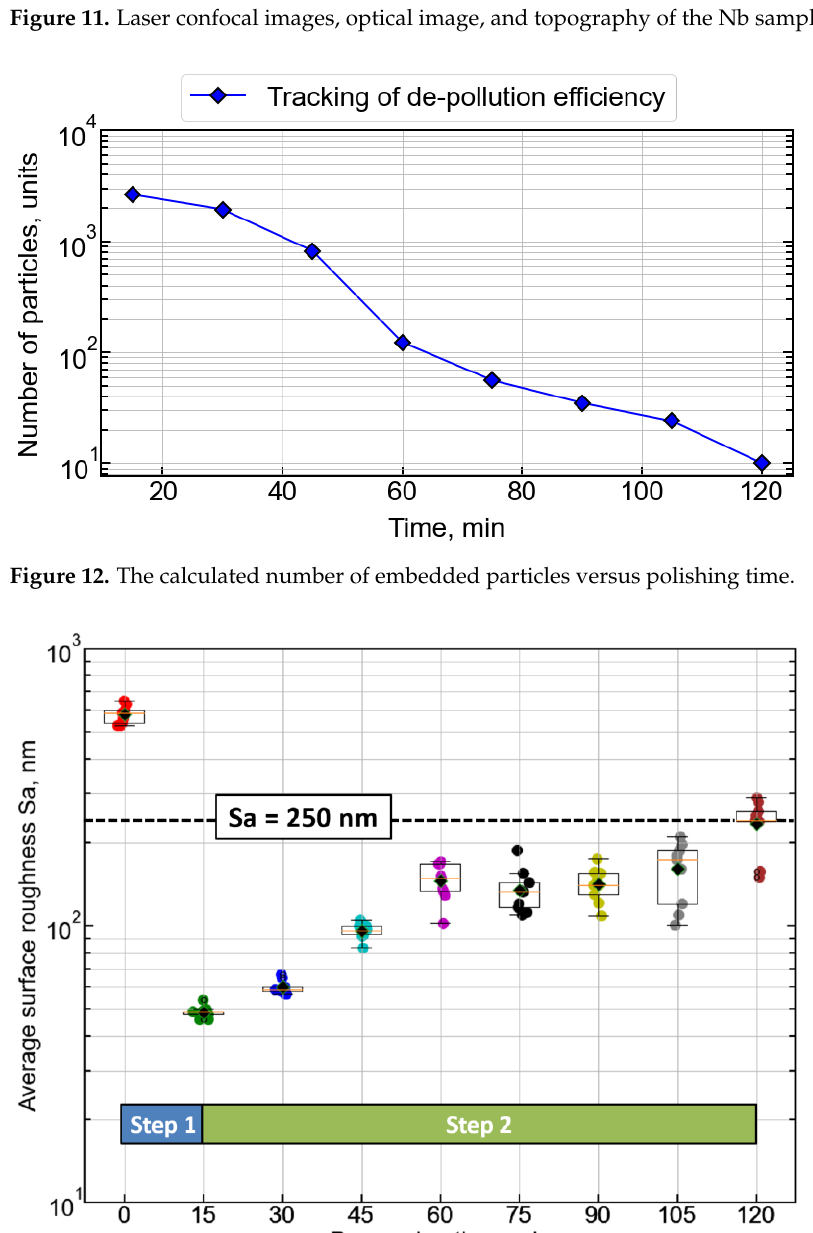
Figure 13. Evolution of the average surface roughness as a function of time.